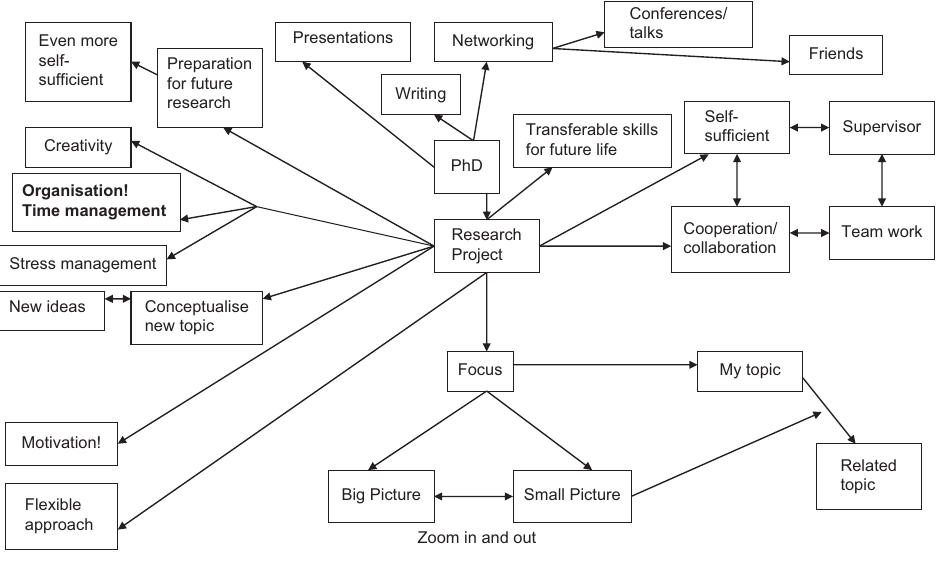
Figure 5. Year two student map of what a Ph.D. is.